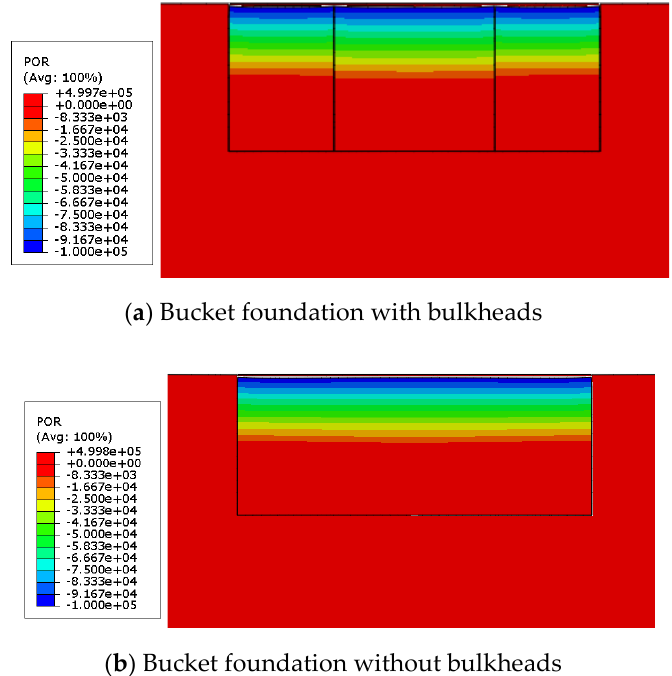
Figure 8. Pore water pressure nephograms of the reinforced soil.